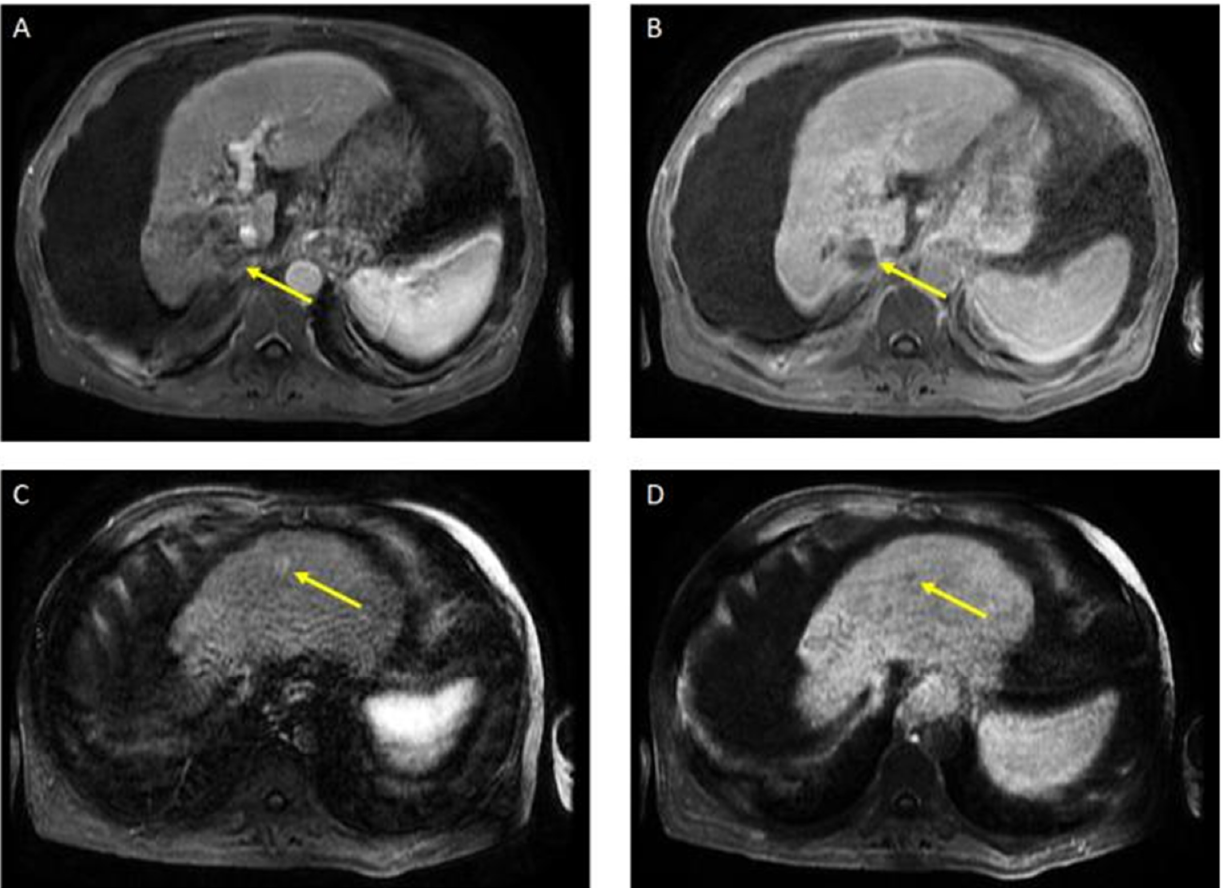
Figure 2. Magnetic resonance imaging of the abdomen. Cirrhosis, splenomegaly, and ascites were noted. Significant interval treatment response. Segment 7 mass has decreased in size (now 3.3 × 3 cm). ( A ) Diffusion-weighted imaging (DWI): decreased diffusion restriction of seg 7 mass; ( B ) (arte- rial)/( C ) (delayed) T1 post-contrast imaging: mass is now hypovascular (captured at the follow-up visit, and 8 weeks after the atezolizumab plus bevacizumab started).